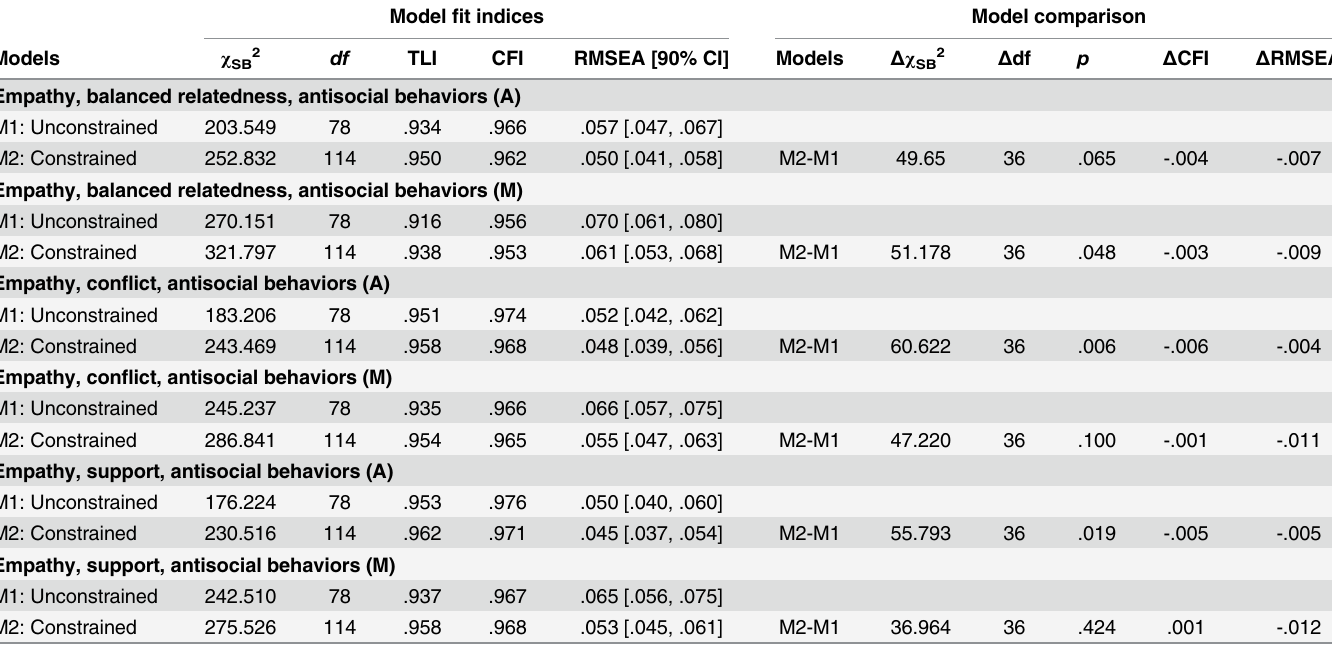
Table 3. Cross-Lagged Models: Fit Indices and Model Comparisons.